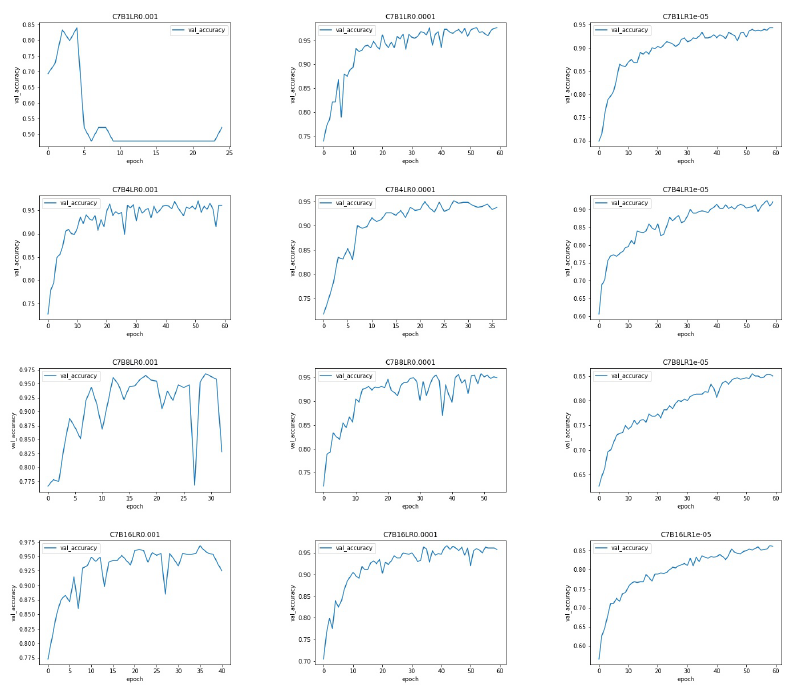
Figure 8. Seven convolution block with different batch number and learning